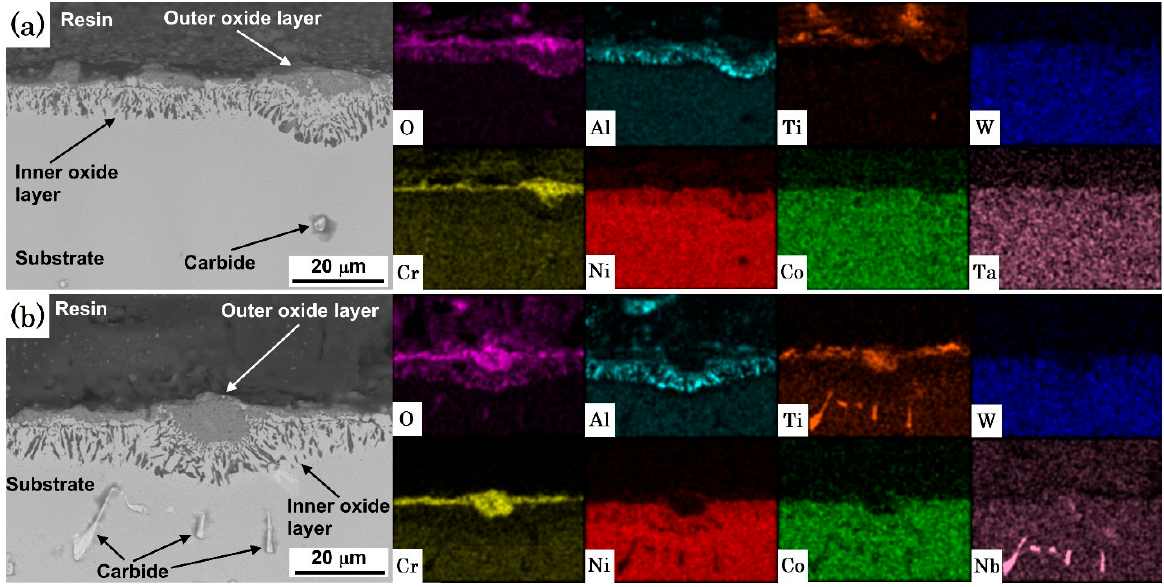
Figure 3. SEM and EDS mapping of elements for 180 cycles at 900 °C on the cross-section of the specimens. ( a ) MAR-M246(Ta), ( b ) MAR-M246(Nb).